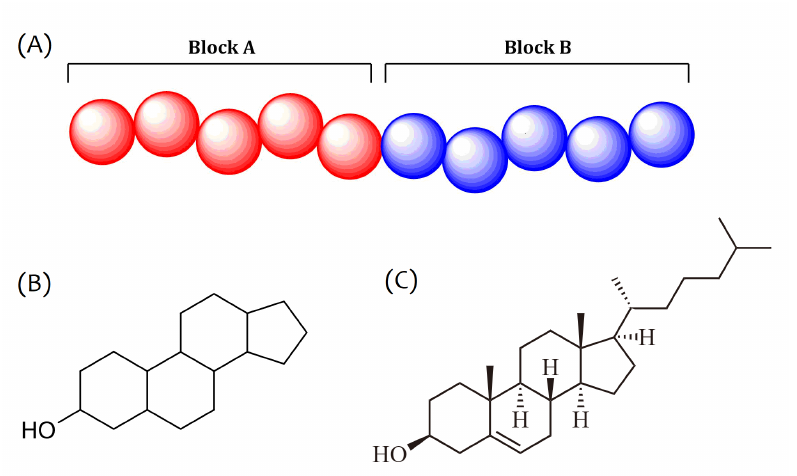
Figure 1. ( A ) Cartoon representation of a block copolymer. The repeating units are bound together by a covalent bond resulting in an ampiphilic molecule. ( B ) Chemical structure of generic sterol and ( C )